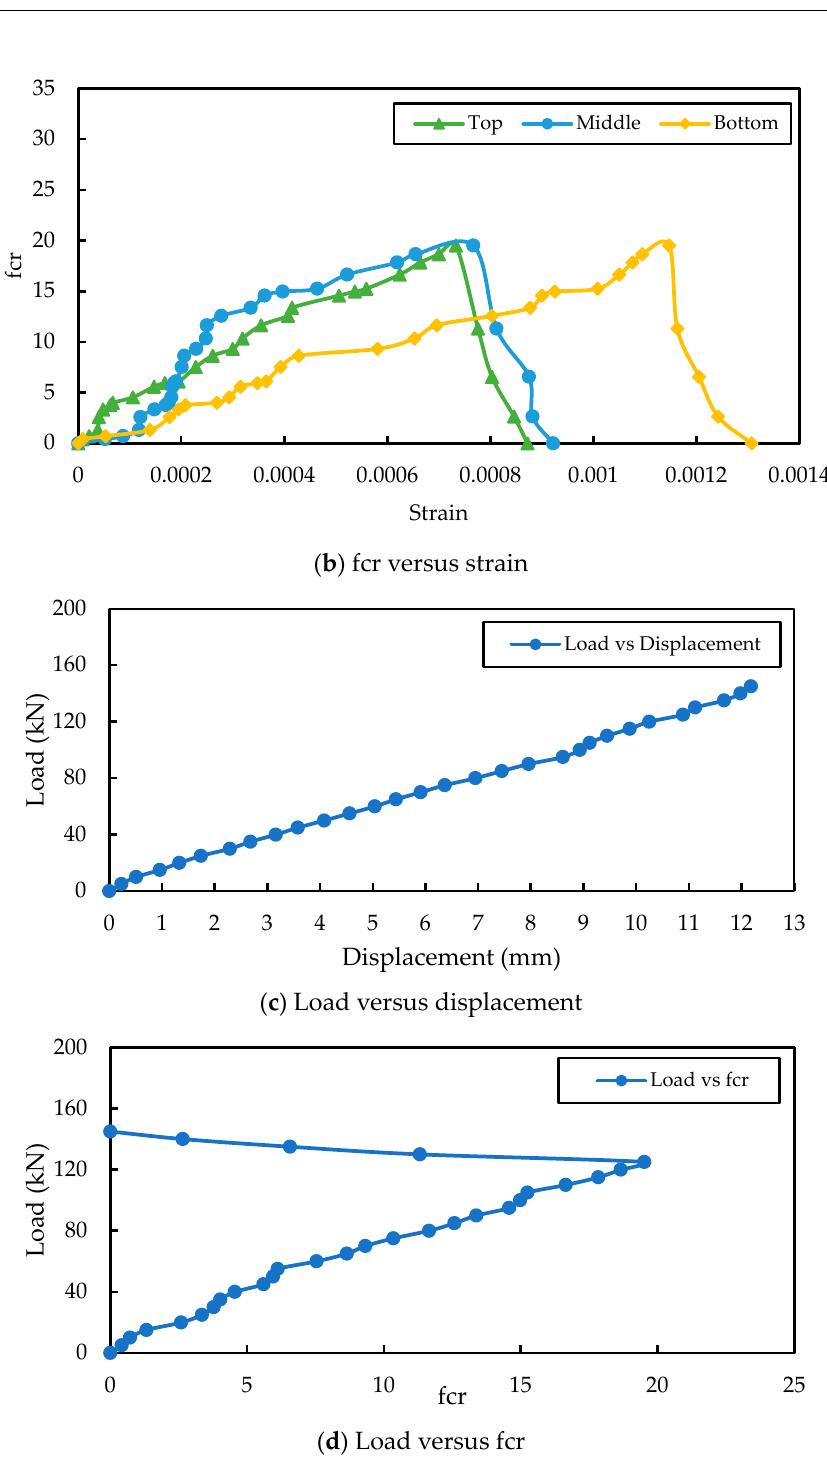
Figure 6. Graphical representation of ( a ) stress vs. strain, ( b ) fcr vs. strain, ( c ) load vs. displacement and ( d ) load versus fcr behaviour of the brass fibre added fresh mortar layer cast on fresh concrete beam of length 1.5 m.